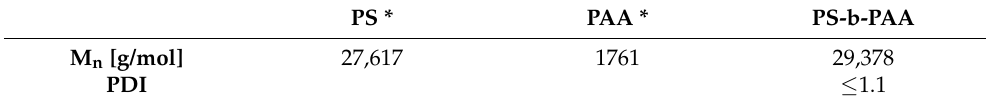
Table 1. Material data of the polystyrene-block-polyacrylic acid copolymer used. PS * PAA * PS-b-PAA M n [g/mol] 27,617 1761